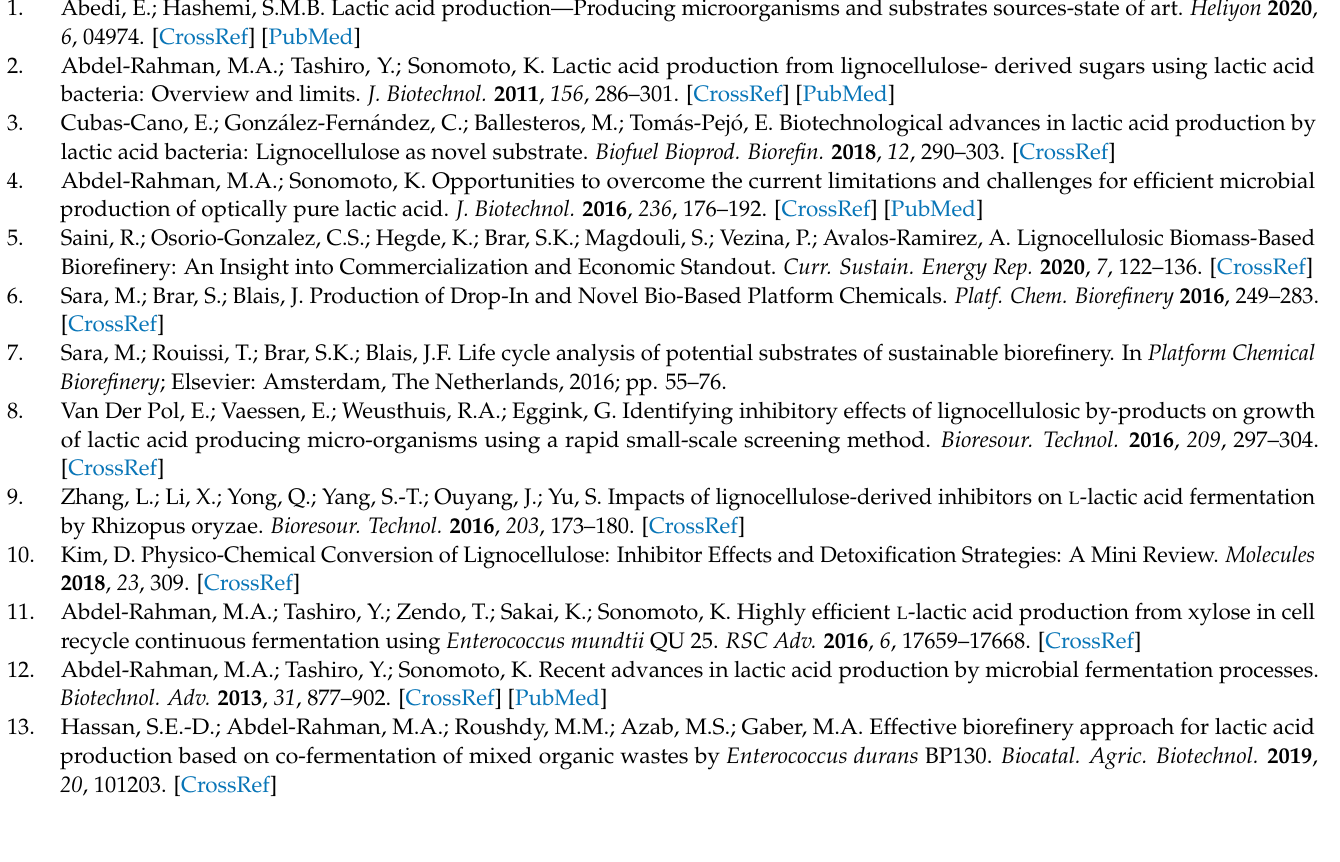
Table S1: Results of API-50 CHL sugar fermentation pattern for isolate Azu-10 after incubation for 48 h at 50 ◦ C, Table S2: Effect of pH value on lactic acid fermentation efficiency by B. coagulans